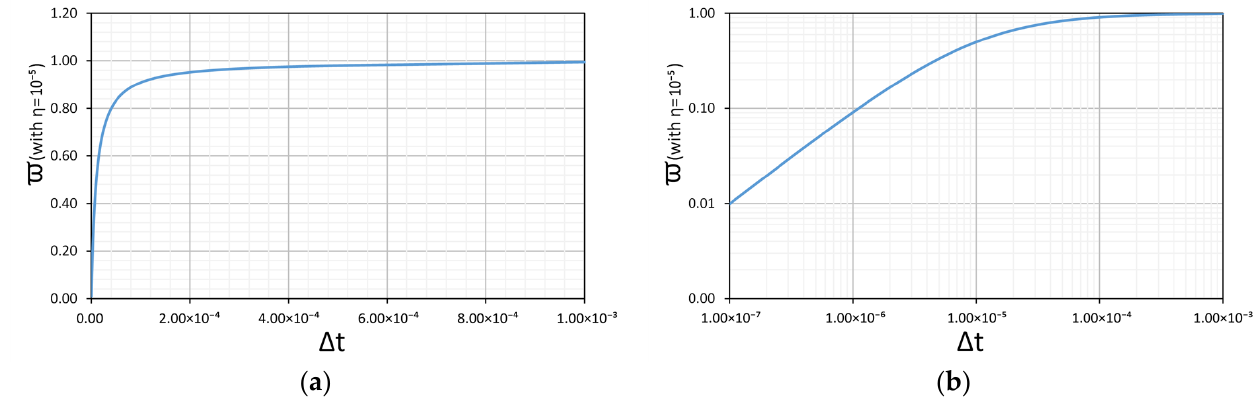
Figure 3. Variation of the correction parameter with the time step increment. ( a ) Normal Scale; ( b ) logarithmic Scale.